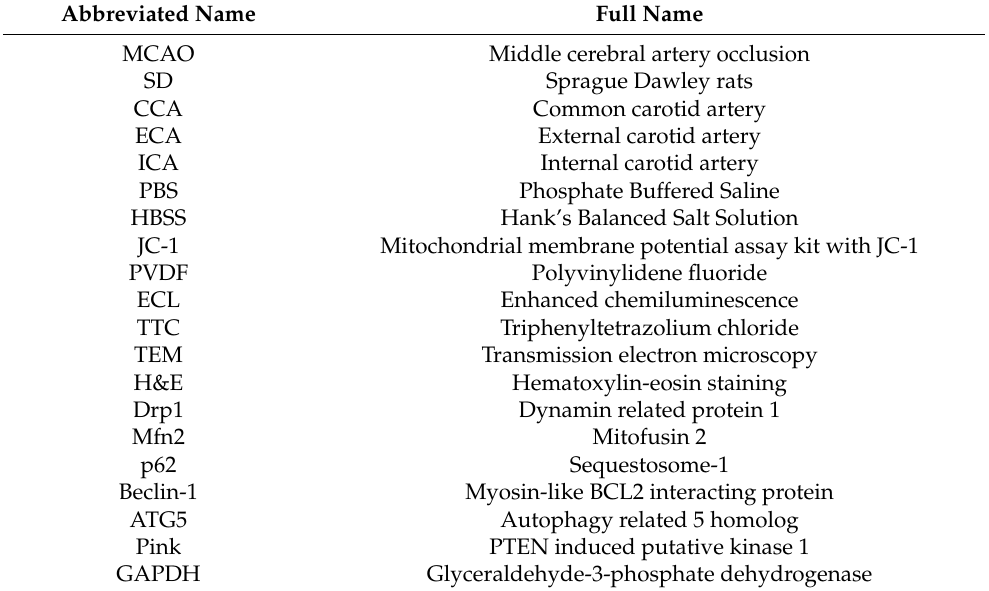
Table 1. List of